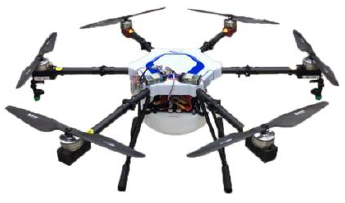
Figure 3. Iteration process to estimate endurance from required power with consideration of battery discharge.